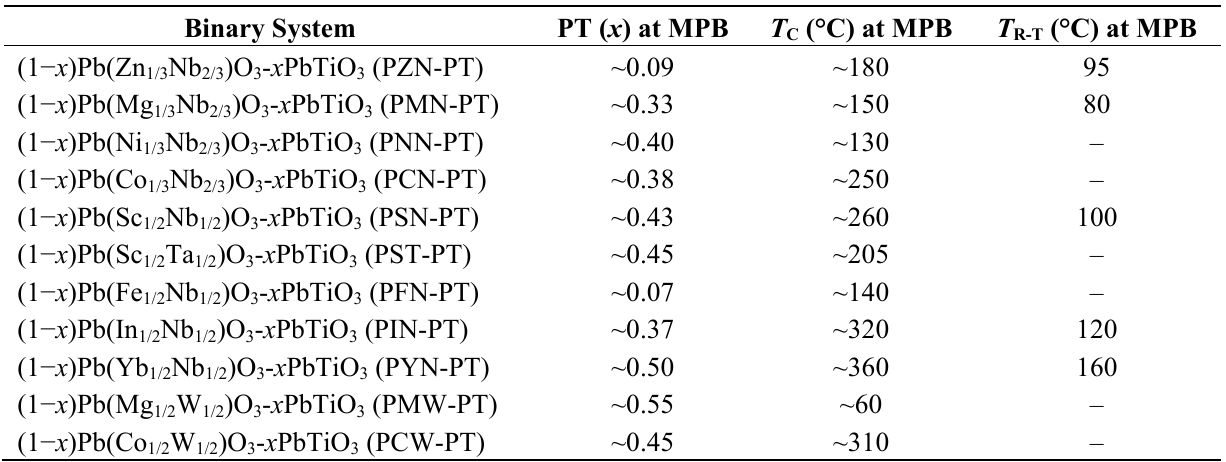
B )O -PT ceramic I II 3